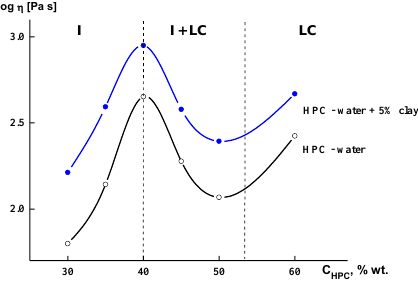
Figure 18. Concentration dependences of the viscosity of the neat and filled with 5% of clay (Na- montmorillonite) HPC solutions.